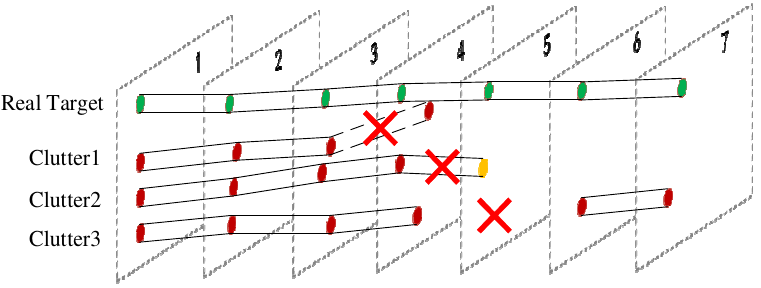
Figure 13. Three cases of false targets based on spatiotemporal characteristics.